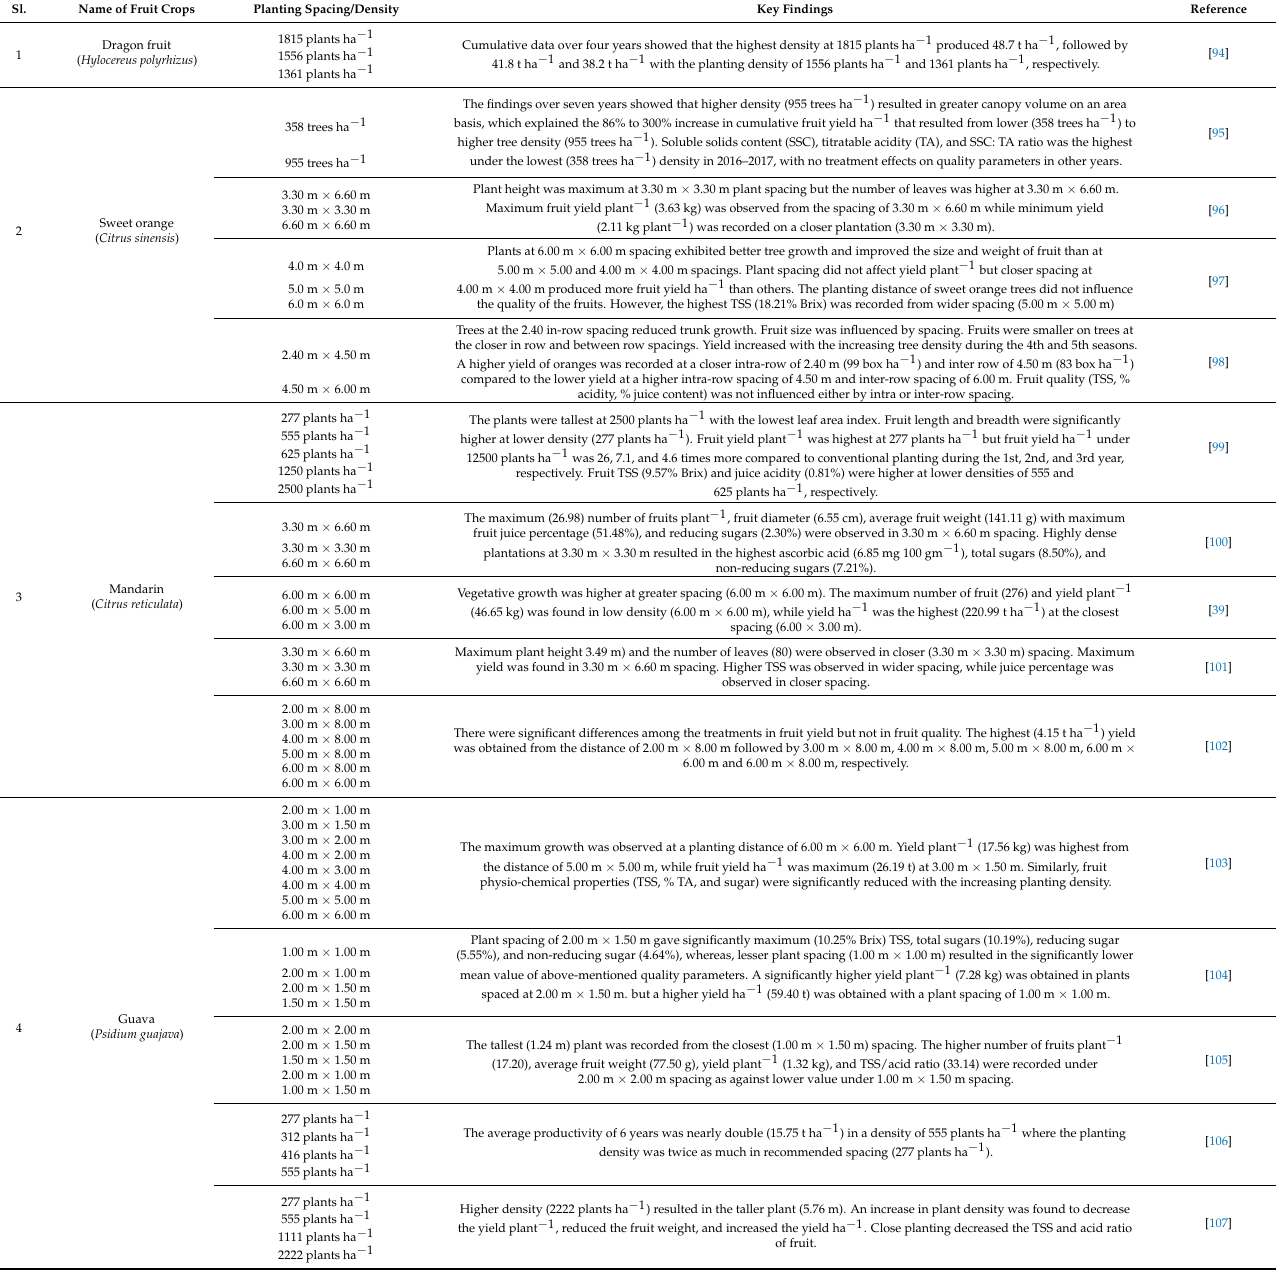
Table 2. Effect of planting density/spacing on growth, yield, and quality of different fruit